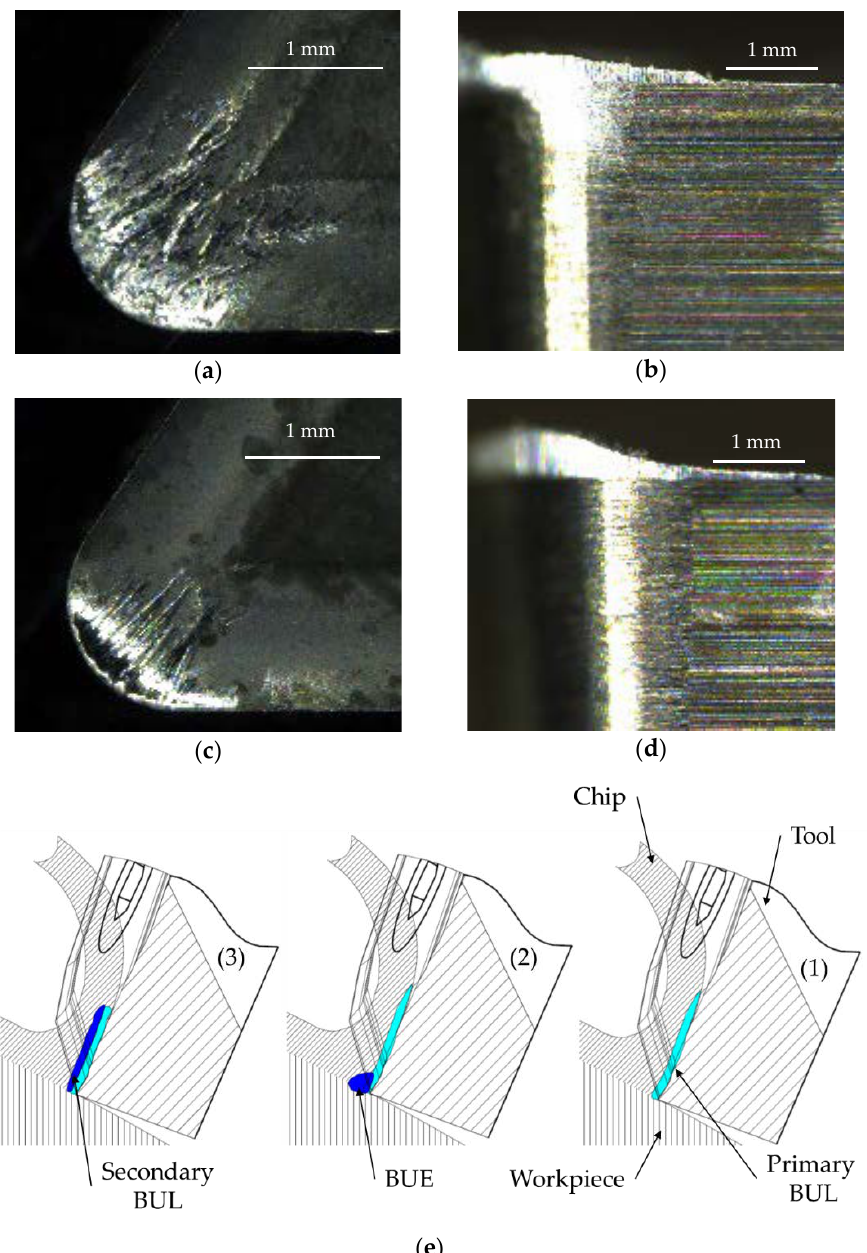
Figure 4. Comparison of built-up layer (BUL) and built-up edge (BUE) for different cases. ( a , b ) Vc = 100 m/min, f = 0.2 mm/r. ( c , d ) Vc = 40 m/min, f = 0.05 mm/r. ( e ) Scheme of the BUL and BUE formation.